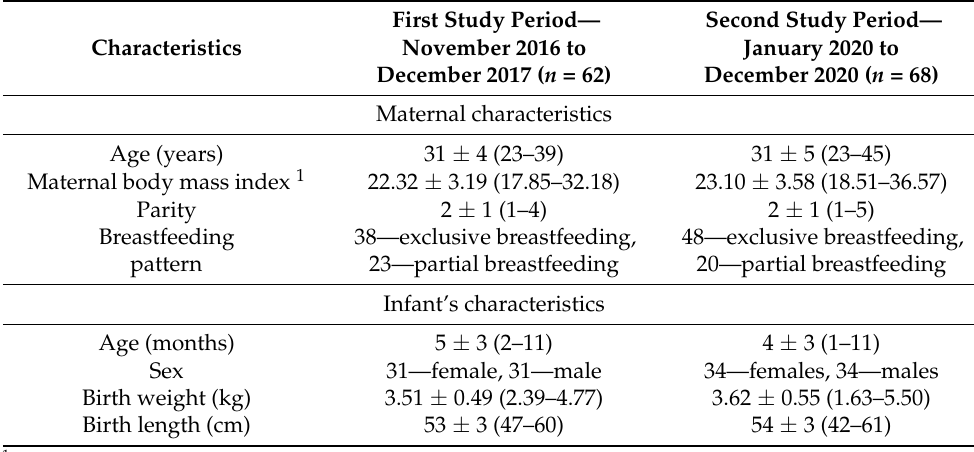
Table 1. Characteristics of the